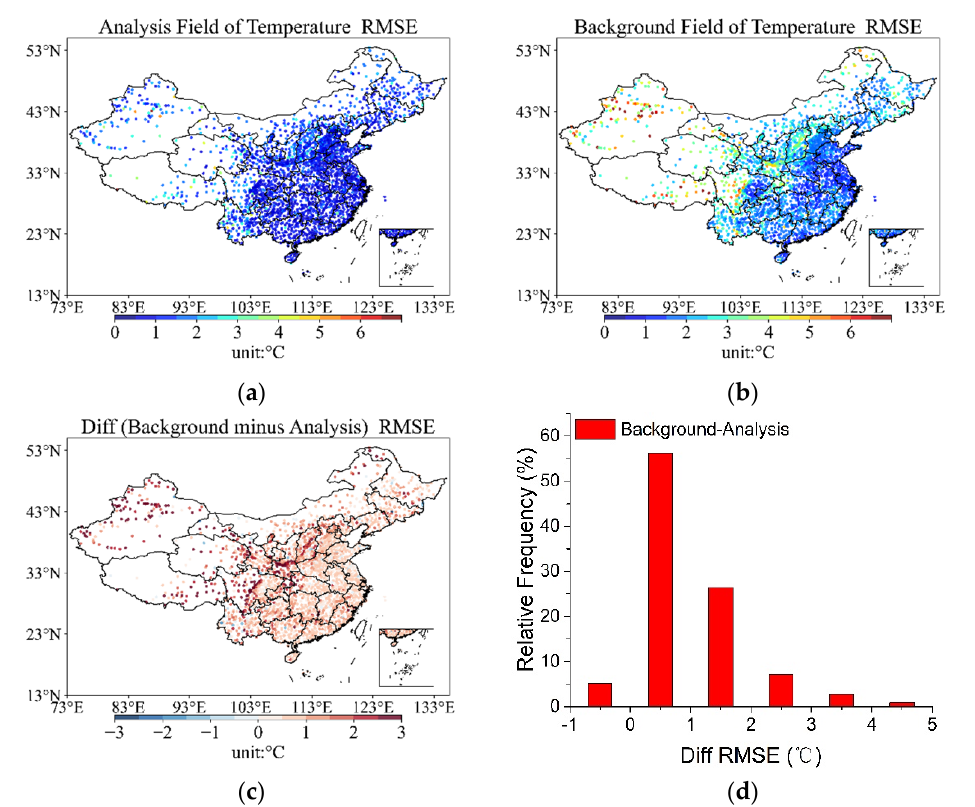
Figure 3. Statistical diagram of RMSE for temperature based on stations: ( a ) spatial distribution of RMSE for analysis field; ( b ) spatial distribution of RMSE for background field; ( c ) spatial distribution of the difference between background field and analysis field for RMSE; ( d ) frequency distribution of the difference between background field and analysis field for RMSE.